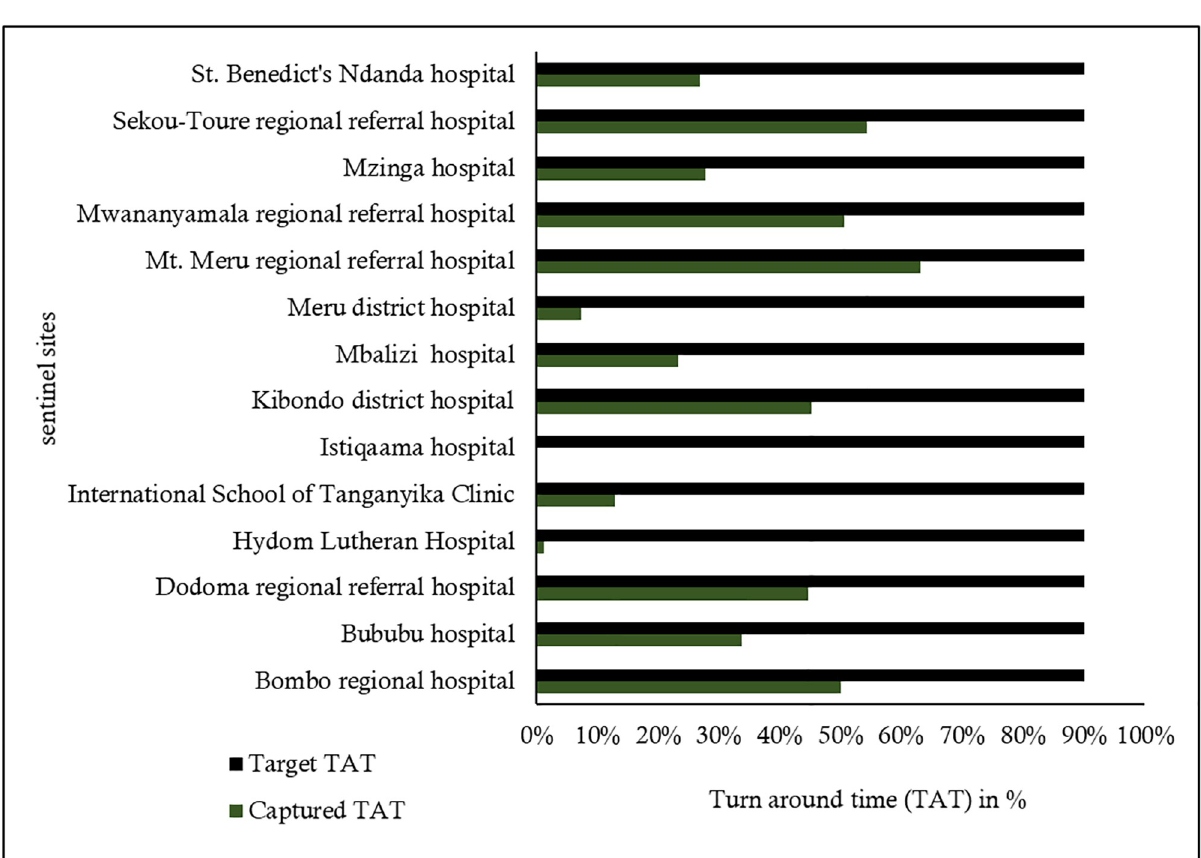
Fig 4. Turnaround coverage among the sentinel sites of the National Influenza Sentinel Surveillance System (NISSS) in Tanzania, January to December 2019.